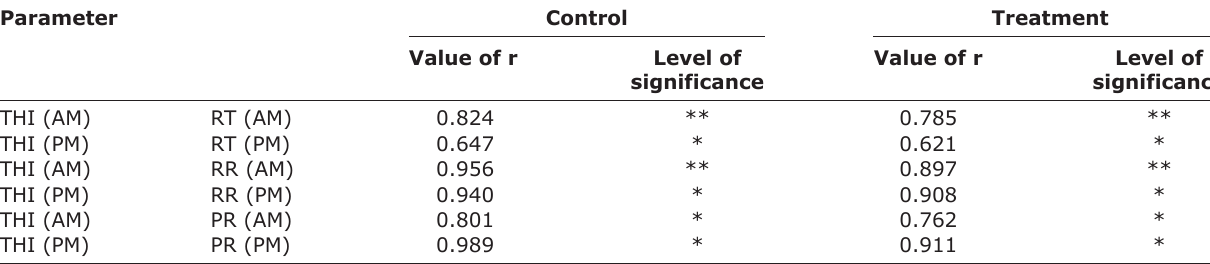
Table-6: Correlation coefficient between THI and physical parameters of stress. Parameter